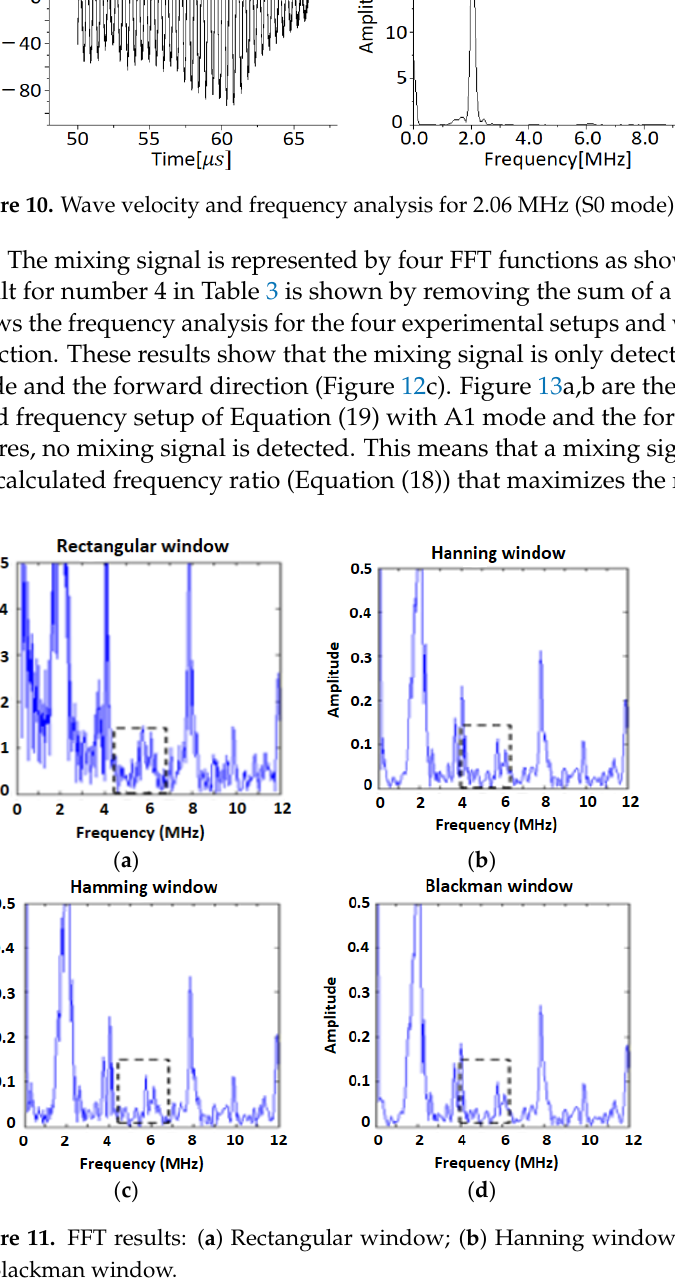
( d ) Figure 11. FFT results: ( a ) Rectangular window; ( b ) Hanning window; ( c ) Hanmming window; ( d ) Blackman window.